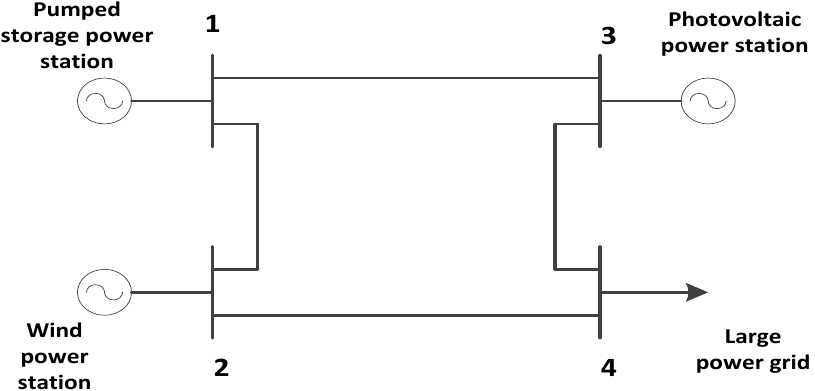
Figure 4. Diagram of the hybrid renewable energy system.